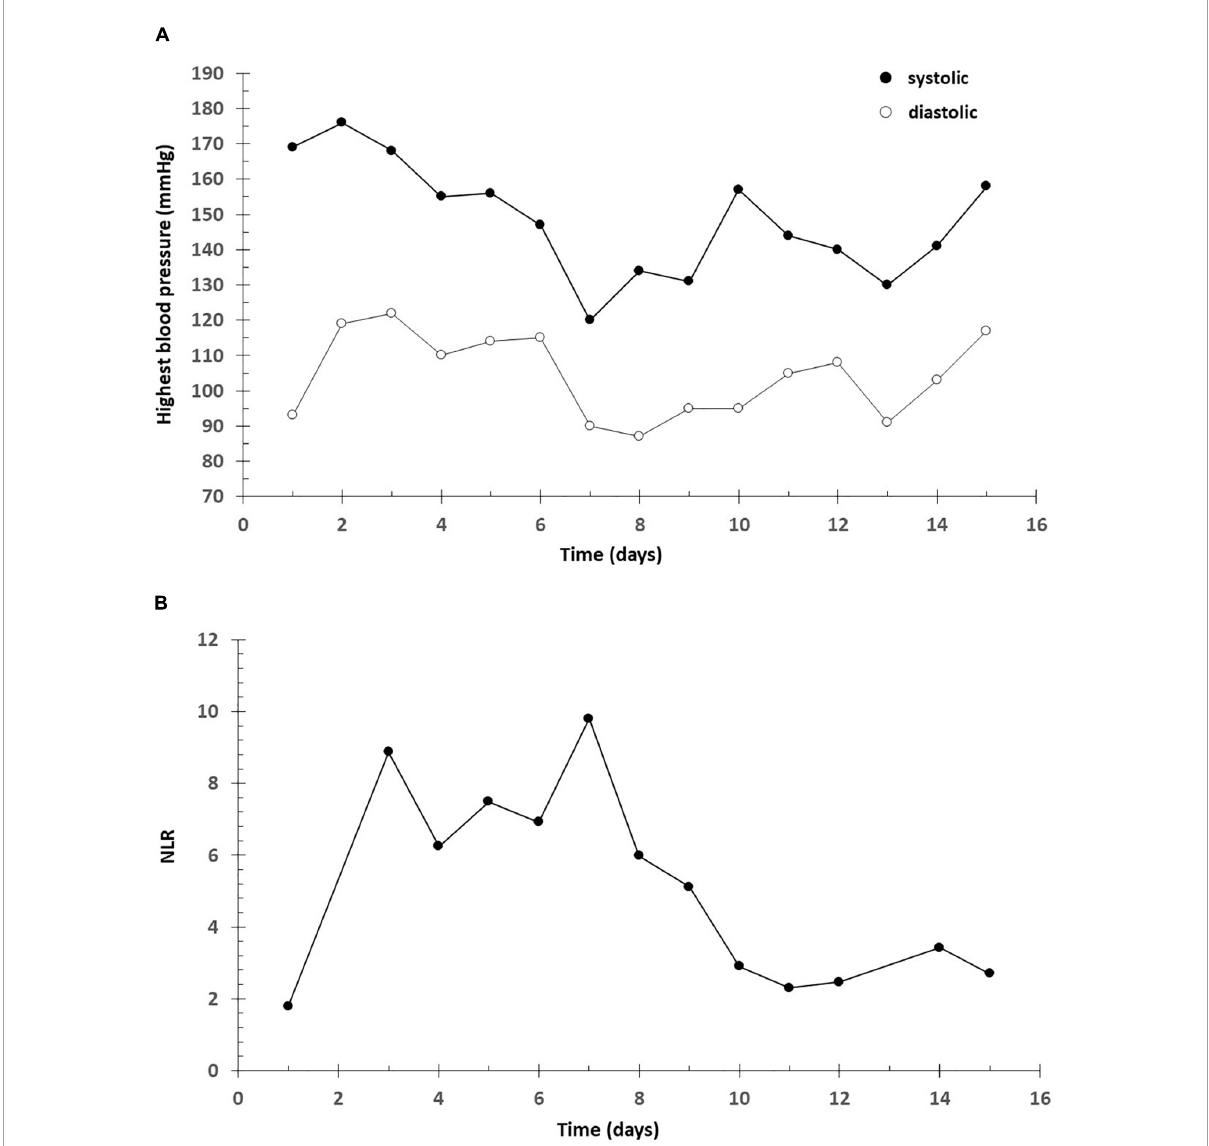
FIGURE1 Highest blood pressure. NLR. (A) Higher blood pressure (mmHg). Systolic ( • ) and diastolic (o) blood pressure. (B) Neutrophil-Lymphocyte Ratio